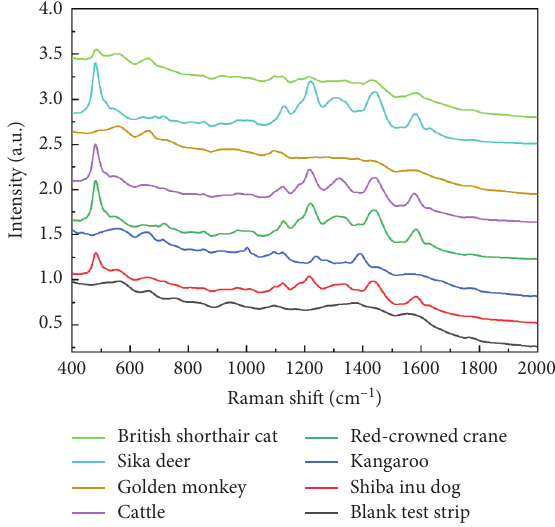
Figure 5: The average Raman spectra of blood samples from seven species of animals.